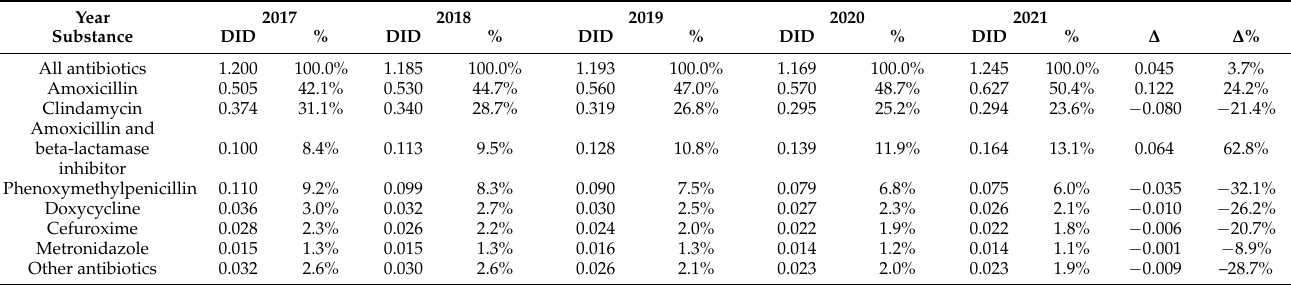
Table 1. Prescription of systemic antibiotics by dentists during 2017 to 2021 in DID. Abbreviations: DID, defined daily doses per 1000 statutory health-insured persons per day; %, share of all prescribed antibiotics; ∆ , difference between 2021 and 2017 DID; ∆ %, percentage difference between 2021 and 2017 DID.